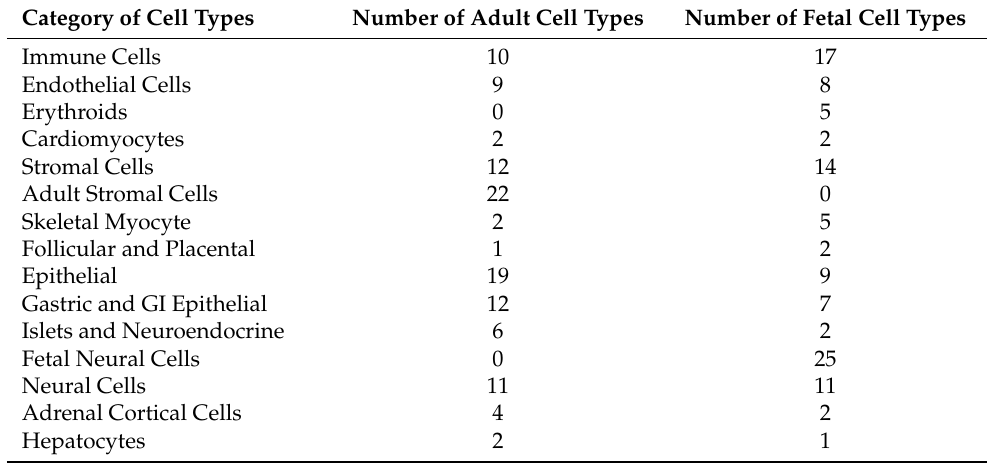
Table 1. Categories of cell types along with number of adult and fetal cell